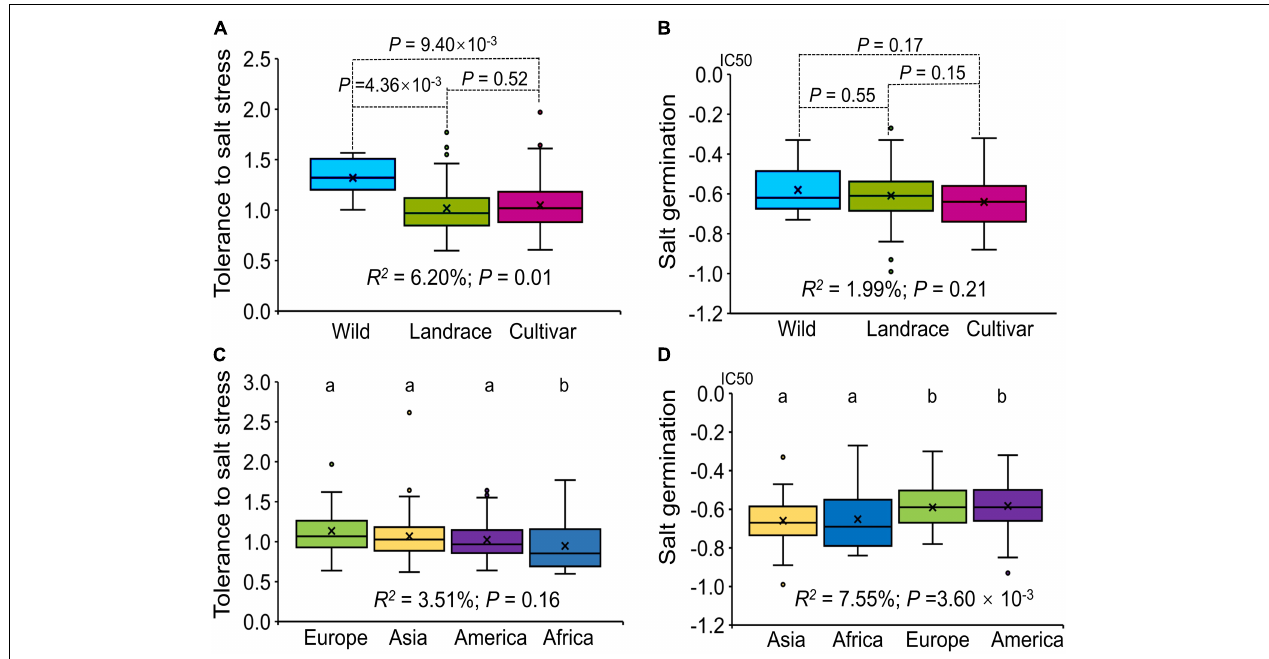
FIGURE 1 | Box plot showing the variation in tolerance to salt stress and germination ability under salt stress evaluated for the association panel. (A) Box plot of the tolerance to salt stress among subgroups (Wild, Landrace, Cultivar) according to breeding status. (B) Box plot of germination ability under salt stress among subgroups (Wild, Landrace, Cultivar). (C) Box plot of the tolerance to salt stress among subgroups (Europe, Asia, America and Africa) according to geographical origin. (D) Box plot of germination ability under salt stress among subgroups (Europe, Asia, America and Africa). The different letters above the boxplots in (C,D) indicate significant differences at the P < 0.05 level according to Duncan’s multiple comparisons